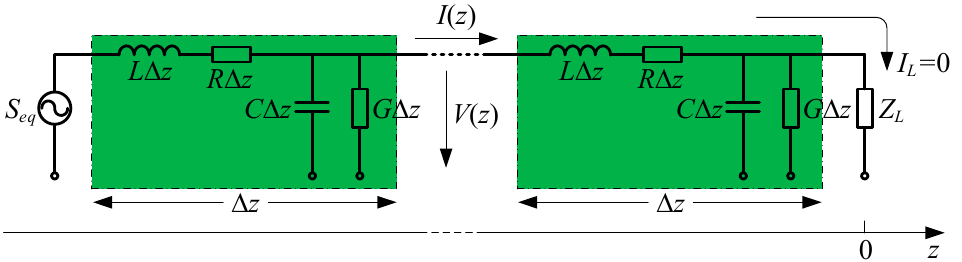
Figure 2. Equivalent circuit of the single-wire power transfer system.